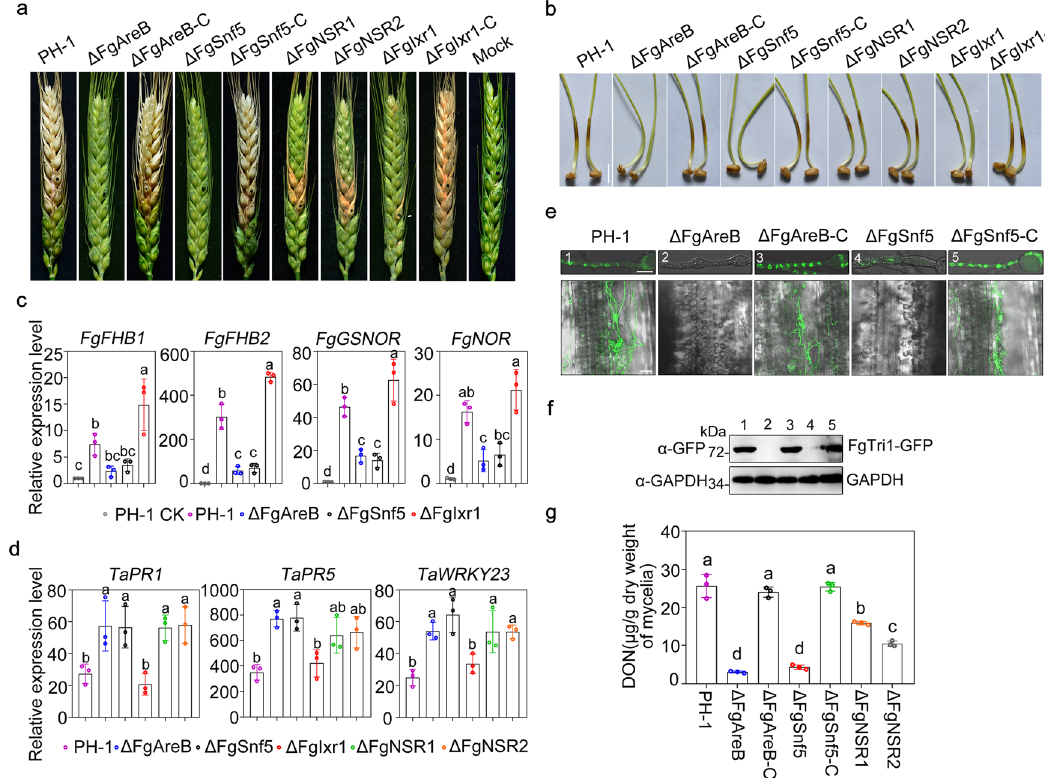
Fig. 6 FgAreB, FgSnf5, and FgNSRs contribute to the virulence of F. graminearum . a Virulence of PH-1, Δ FgAreB, Δ FgAreB-C, Δ FgSnf5, Δ FgSnf5-C, Δ FgNSR1, Δ FgNSR2, Δ FgIxr1, and Δ FgIxr1-C strains on wheat head. The infected wheat heads were photographed 15 day-post-inoculation (dpi). The black dot represents the inoculated site on each wheat head. Sterile water used as control (Mock). The experiment was repeated twice independently with similar results. b Virulence of PH-1, Δ FgAreB, Δ FgAreB-C, Δ FgSnf5, Δ FgSnf5-C, Δ FgNSR1, Δ FgNSR2, Δ FgIxr1, and Δ FgIxr1-C strains on wheat